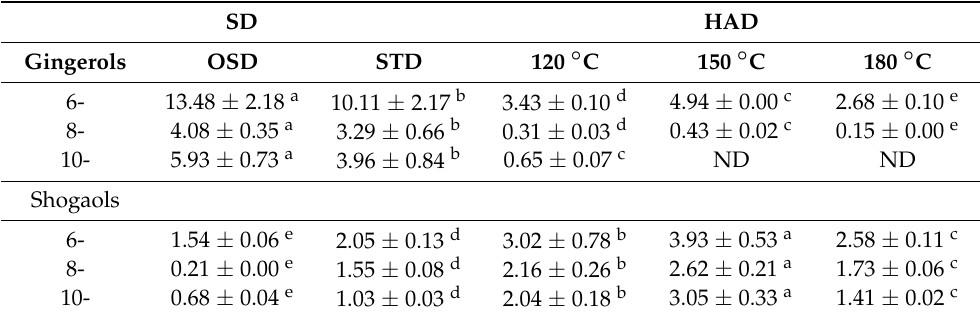
Table 1. Quantification of 6-, 8-, and 10-gingerols, as well as 6-, 8-, and 10-shogaols in ginger dried with different temperature.